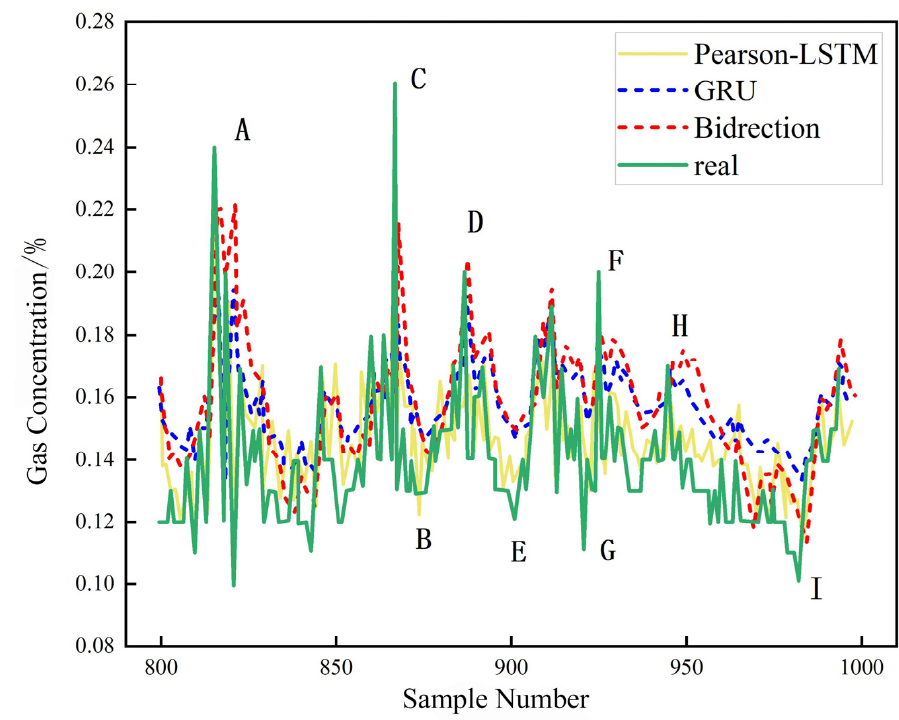
Figure 9. Test results comparison for the three models.